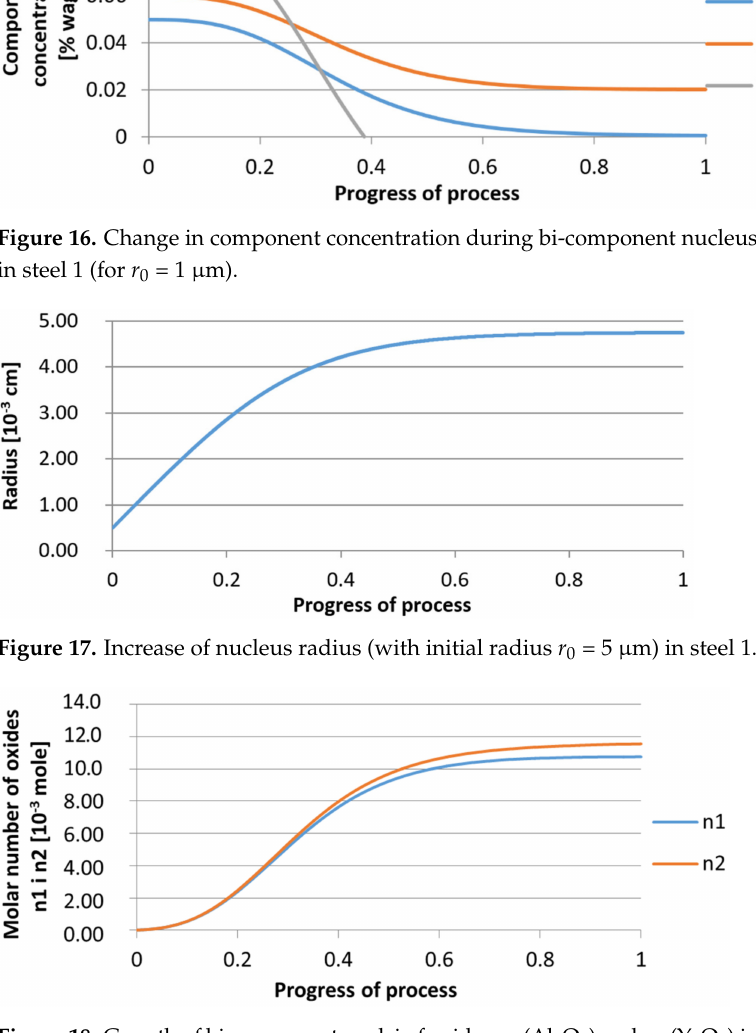
Figure 18. Growth of bi-component nuclei of oxides n 1 (Al 2 O 3 ) and n 2 (Y 2 O 3 ) in steel 1 (for r 0 = 5 µ